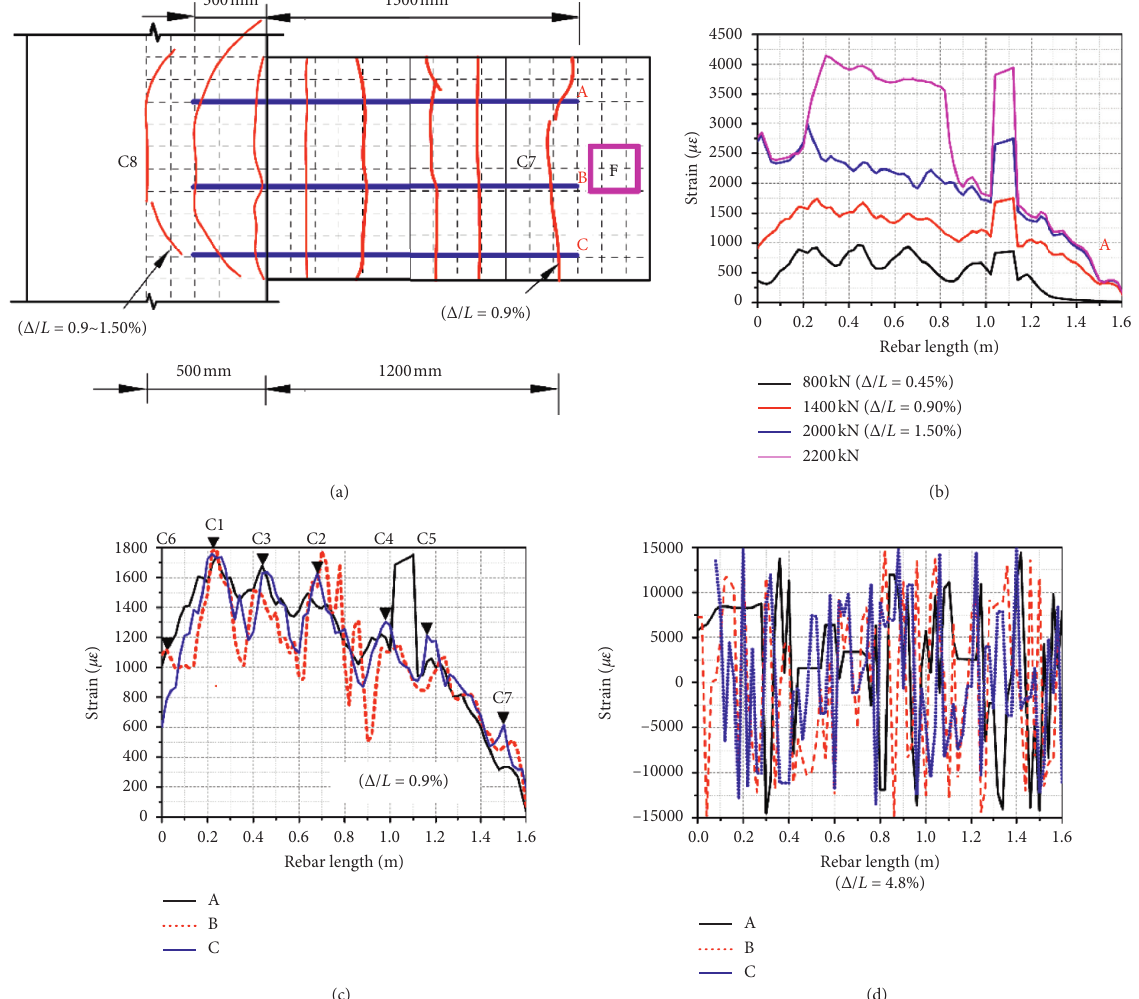
Figure 9: Damage status at 1.5% drift (a), strain profile measured in top fiber A at drift levels below 1.5% (b), and strain profile measured in top fibers A, B, and C at 0.9% and 4.8% drift levels (c,